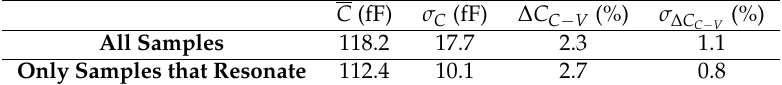
Table 1. Capacitance and C-V variation figures